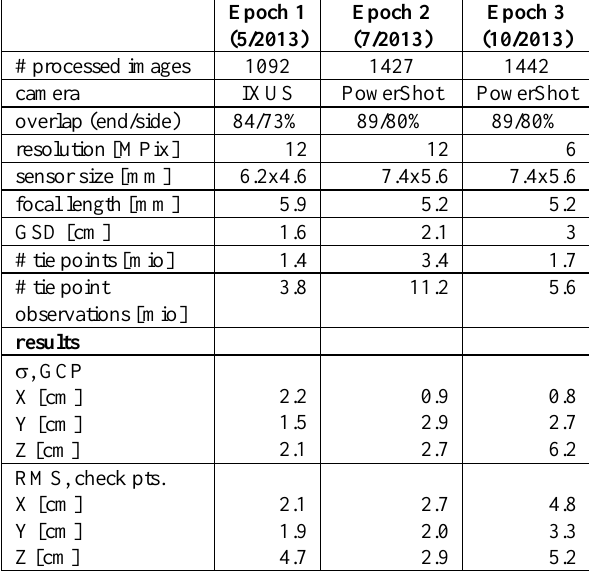
Table 1: Results of bundle adjustment, different